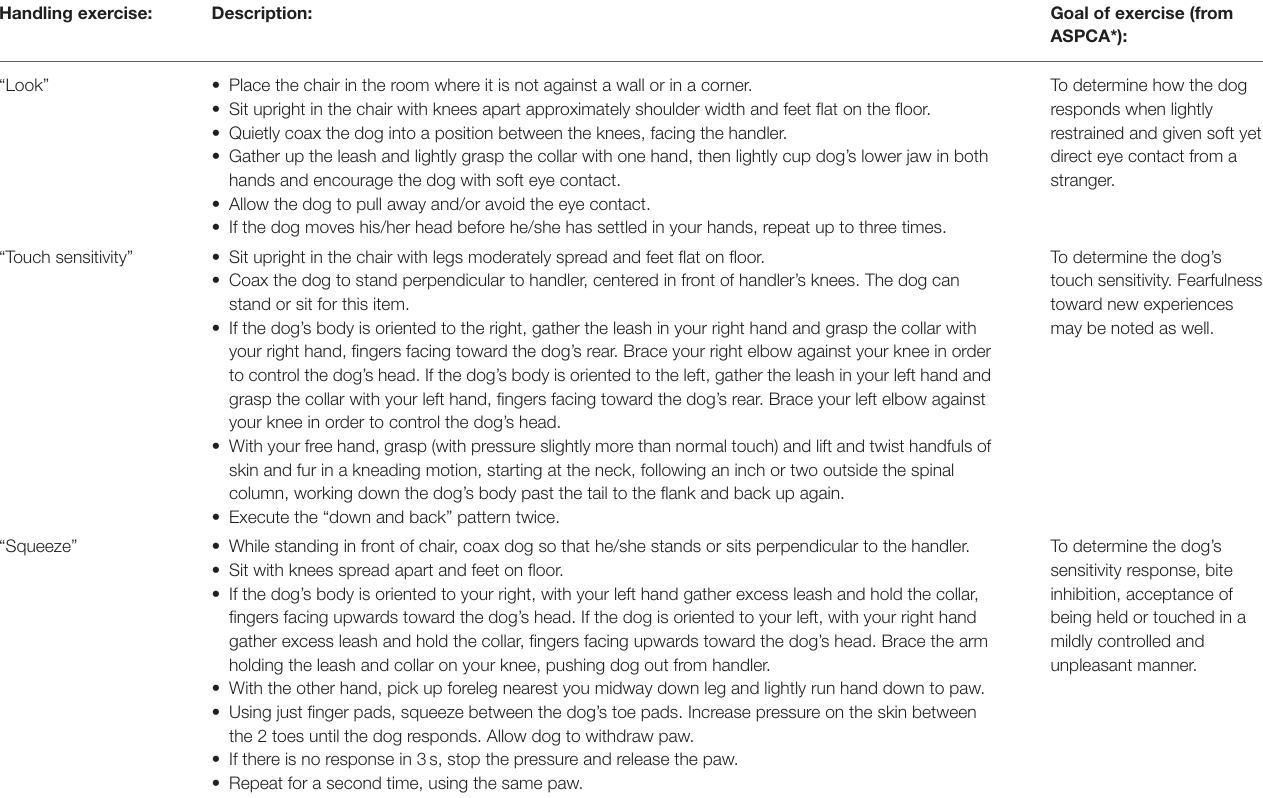
TABLE 1 | Handling exercises performed during simultaneous cardiac and behavioral data collection. Handling